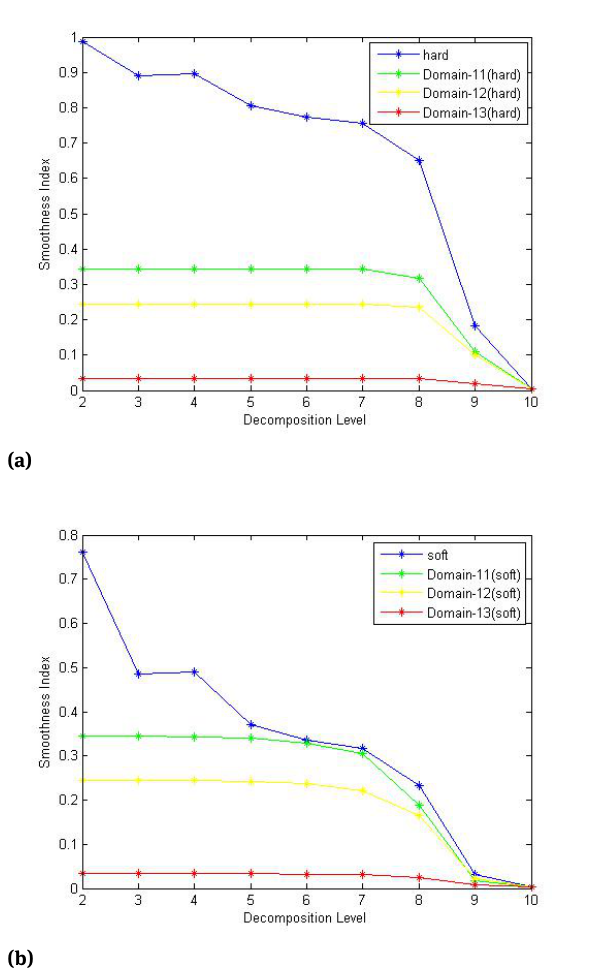
Figure 6: Comparison of The smoothness index between wavelet threshold results and domain-wavelet results by using hard thresh- old (a) and soft threshold